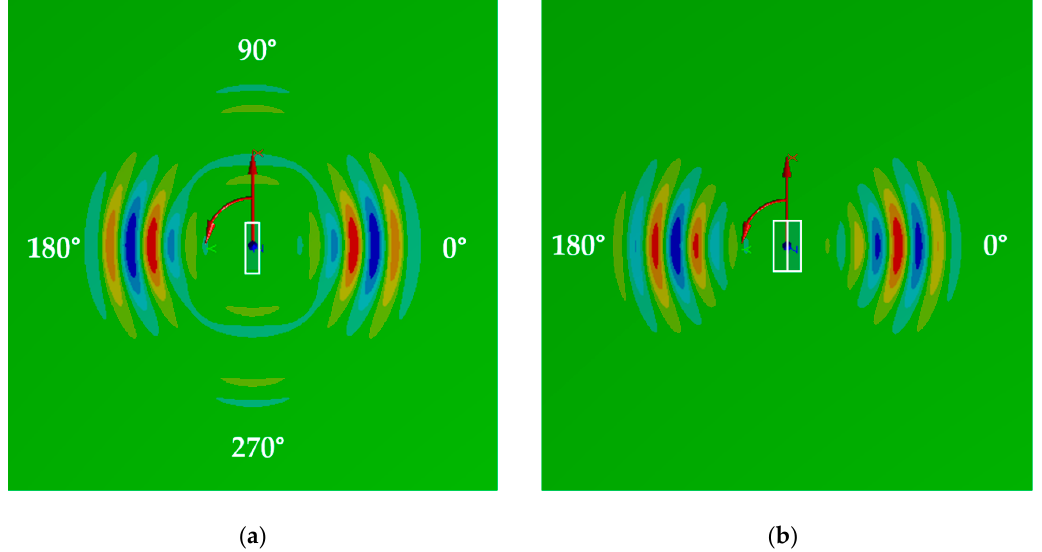
Figure 14. The tangential component of the simulated wave field at a time of 50 µs for ( a ) the original SHPFP and ( b ) the dual SHPFP. The excitation has a center frequency of 80 kHz. For the complete videos of the wave propagation, see the section Supplementary Materials at the end of the paper.